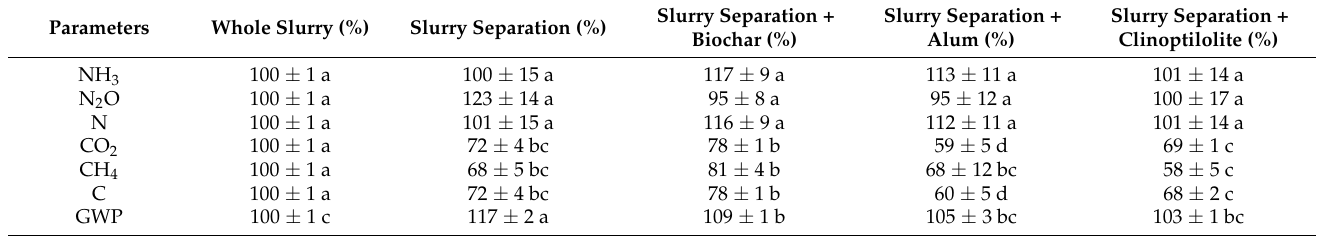
Note: n = 3: three replications per treatment. Values presented with different lowercase letters within rows and are significantly different ( p < 0.05) by Tukey test. N: NH 3 + N 2 O. C: CO 2 + CH 4 . GWP: global warming